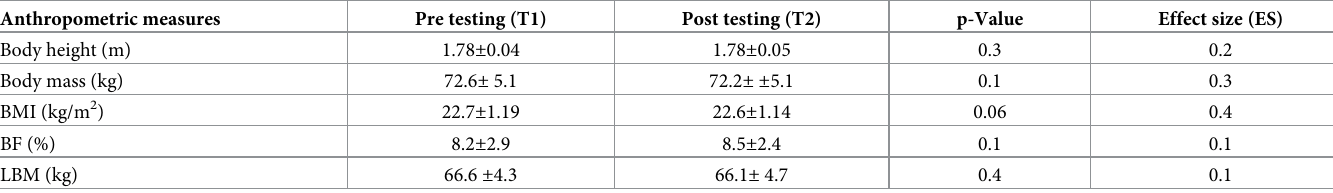
Table 2. Effects of a congested period of match play on soccer players’ body height, body mass index (BMI), body fat percentage (BF%), and lean body mass (LBM). Anthropometric